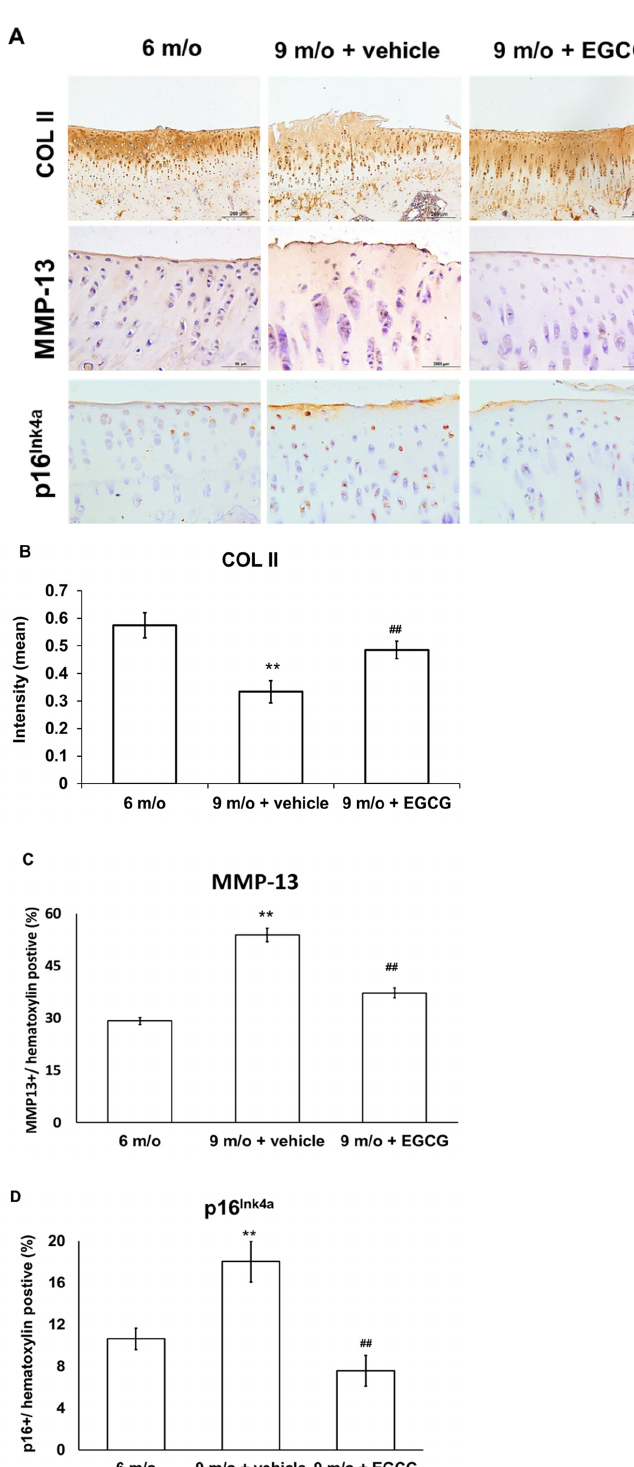
Figure 7. Immunohistochemistry (IHC) of Col II, MMP-13, and p16 Ink4a in the cartilage samples from animals treated with PBS at 6 months of age and 9 months of age and animals treated with EGCG at 9 months of age. ( A ). The representative micrographs of Col II, MMP-13, and p16 Ink4a of the proximal tibia of three groups. The intensity of stained Col II and the positive-stained cell ratio of MMP-13 and p16 Ink4a proteins were measured and compared among groups. The results of Col II are shown in ( B ), MMP-13 in ( C ), and p16 Ink4a in ( D ) ( n = 8 in each group; ** p < 0.01 versus animals at 6 months of age; ## p < 0.01 versus animals treated with PBS at 9 months of age).